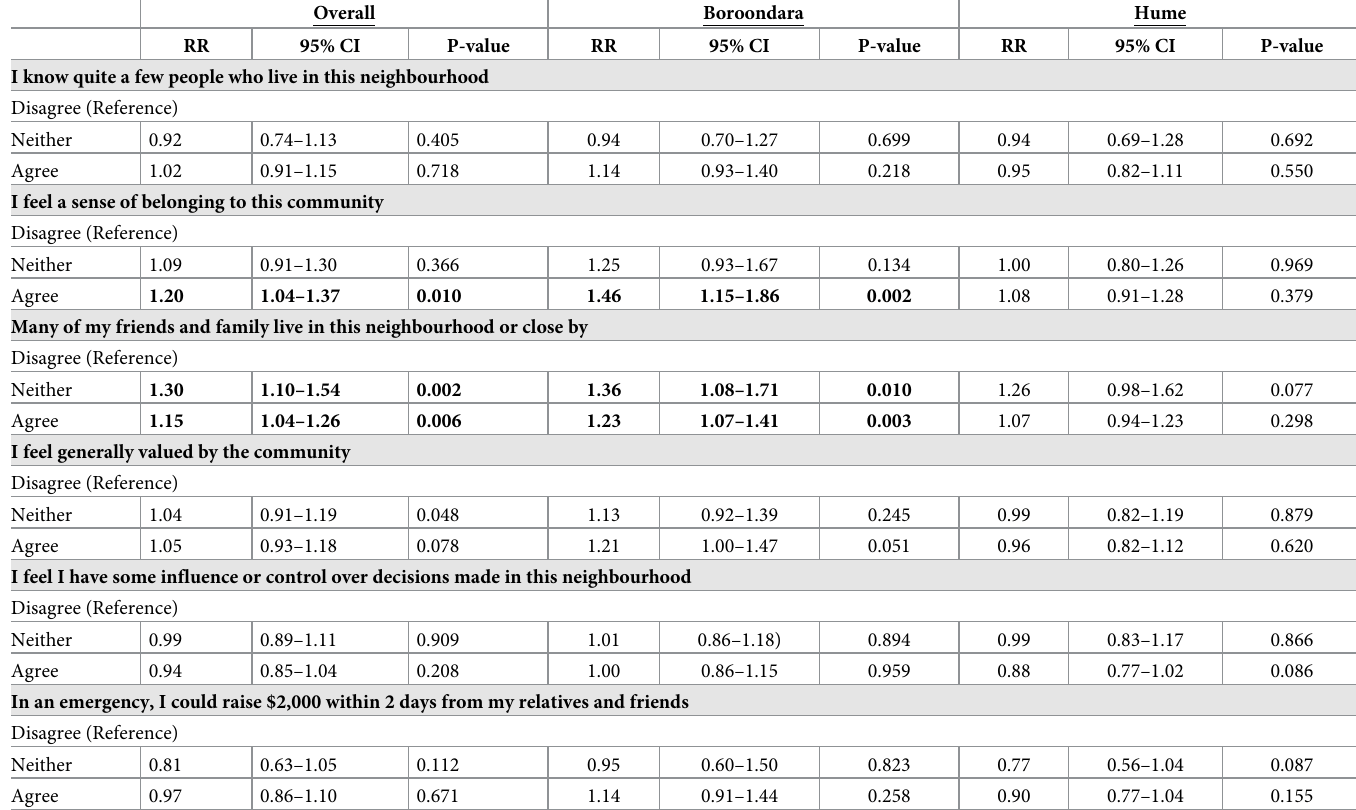
Table 1. Multivariate negative binomial regression results–perceived community